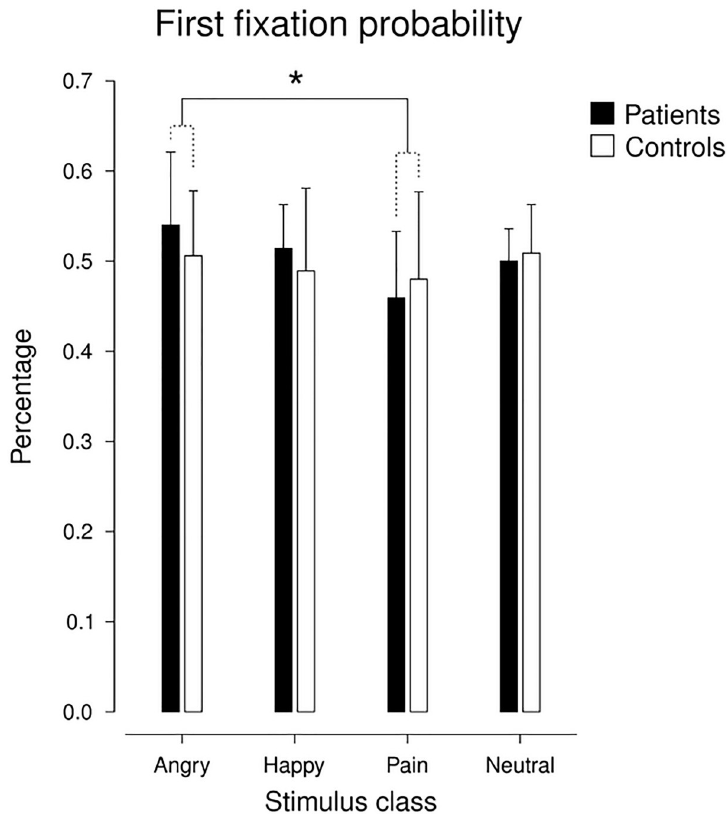
Fig 1. Means and SDs of the first fixation probabilities for angry, happy, and pain faces vs. paired neutral faces both for pain patients and controls. � p < 0.05.